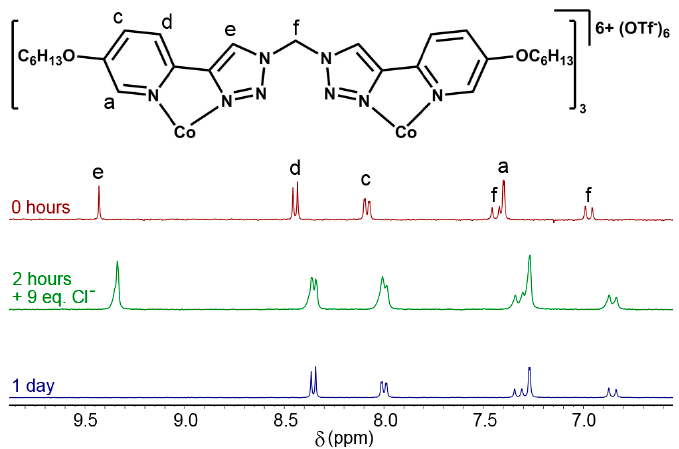
Figure 3. Partial stacked 1 H-NMR (400 MHz, 298 K, D 2 O) of [Co 2 L2 3 ](OTf) 6 in the presence of Cl − anions.